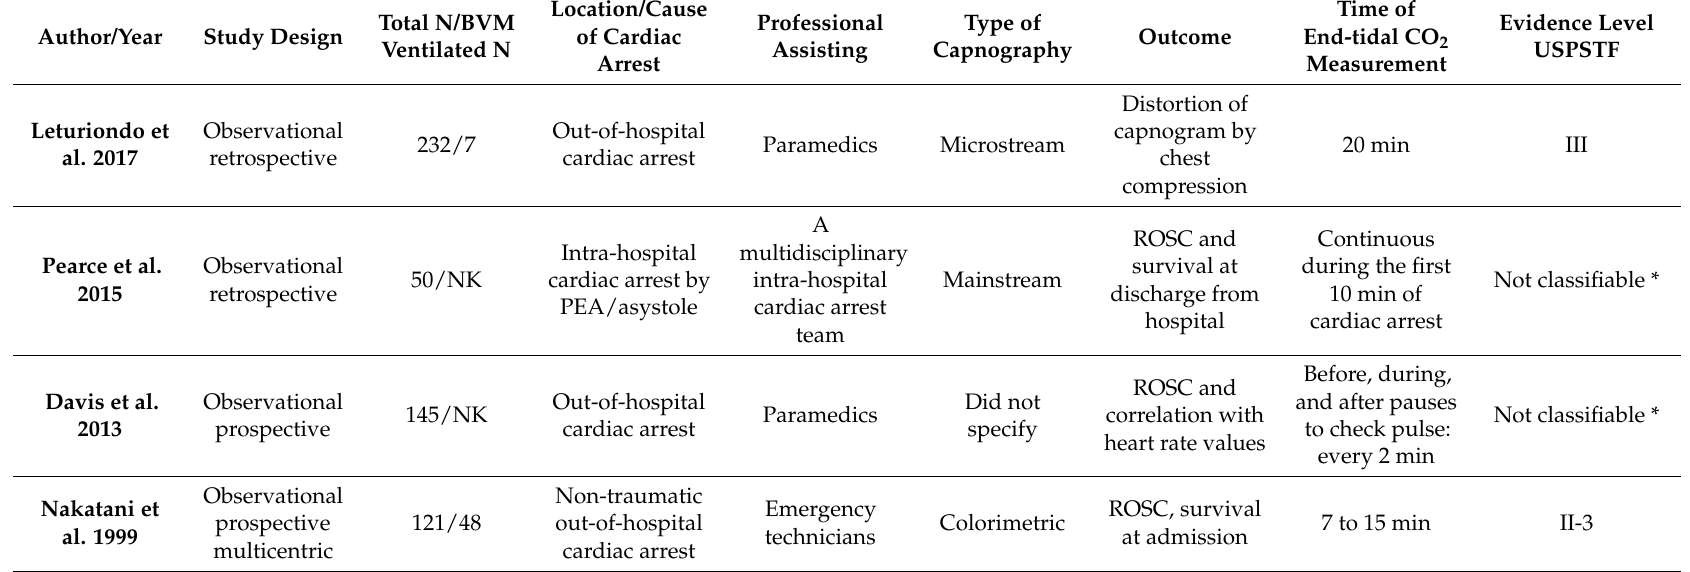
Table 1. Relationship of variables analyzed in the adult studies with evidence levels, and evidence level according to